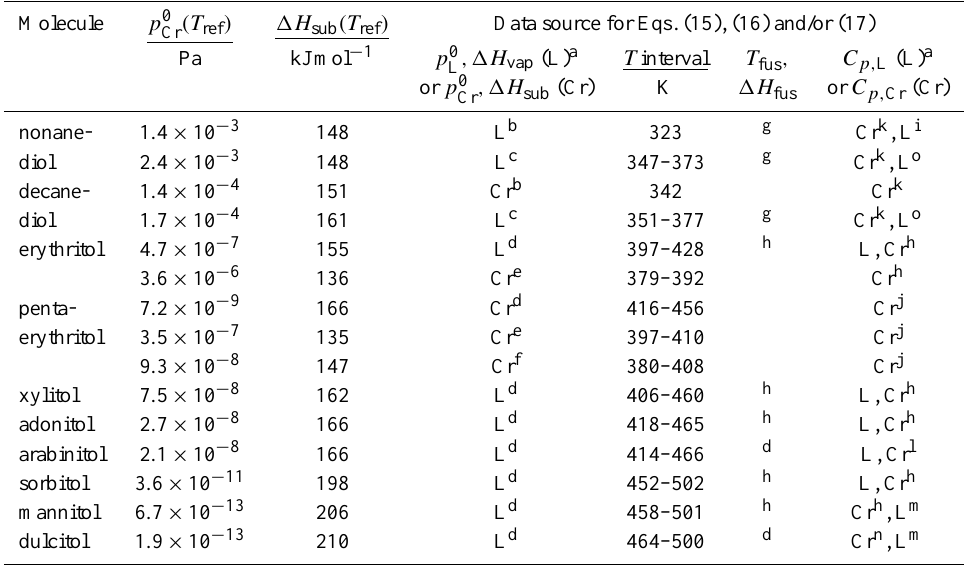
Table 3. Solid state pressure and enthalpy of sublimation of polyols, obtained from Eqs. (15), (16) and/or (17), at T ref = 298 . 15K, and reference to the data used to obtain them. C p, g is estimated by the method of Benson (1976). (T ref ) (cid:49)H sub (T ref ) Data source for Eqs. (15), (16) and/or Molecule p 0 Cr